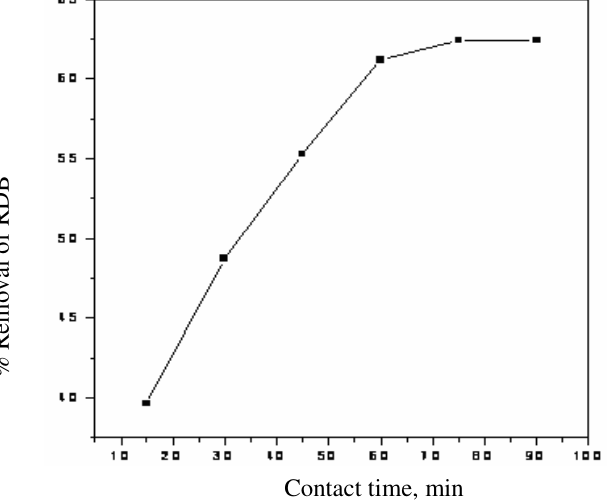
Figure 1 . Effect of contact time on the removal of RDB by